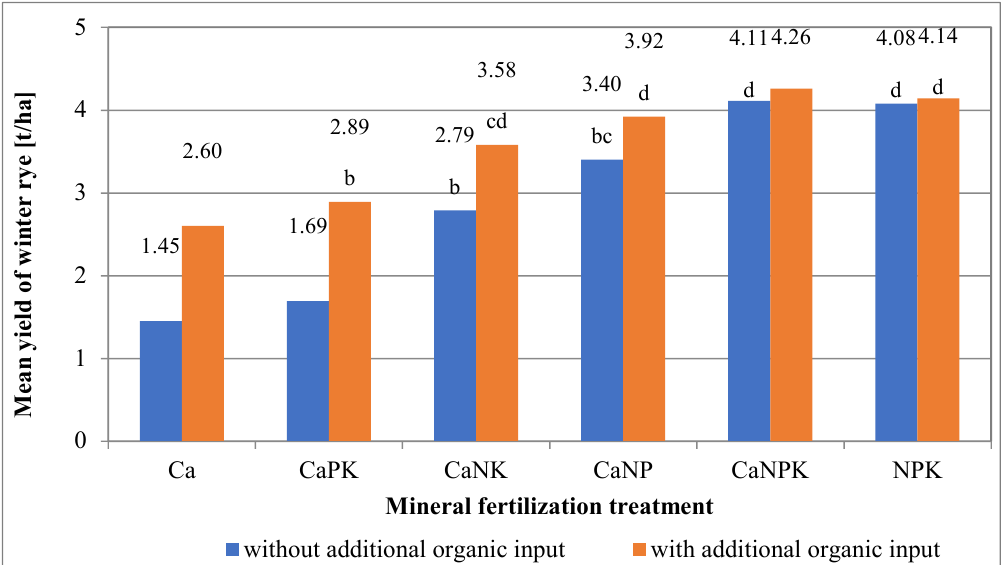
Figure 2. Mean yield of winter rye depending on the mineral fertilization treatment without and with additional organic input (Skierniewice Long-Term Experiment ‘LTE’ 1966–2015). Different letters indicate significant ( p < 0.05) differences between the treatments (combinations of mineral and organic fertilization).